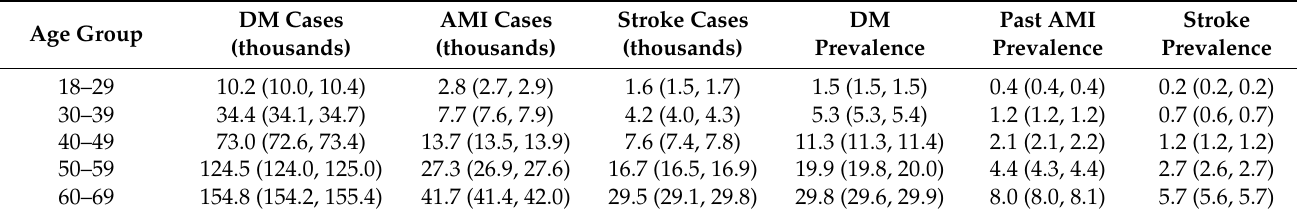
Table 2. Estimated case numbers and prevalence of DM, past AMI and stroke for those aged 18–69 in 2020 stratified by age group. Brackets indicate the 95% confidence intervals over 100